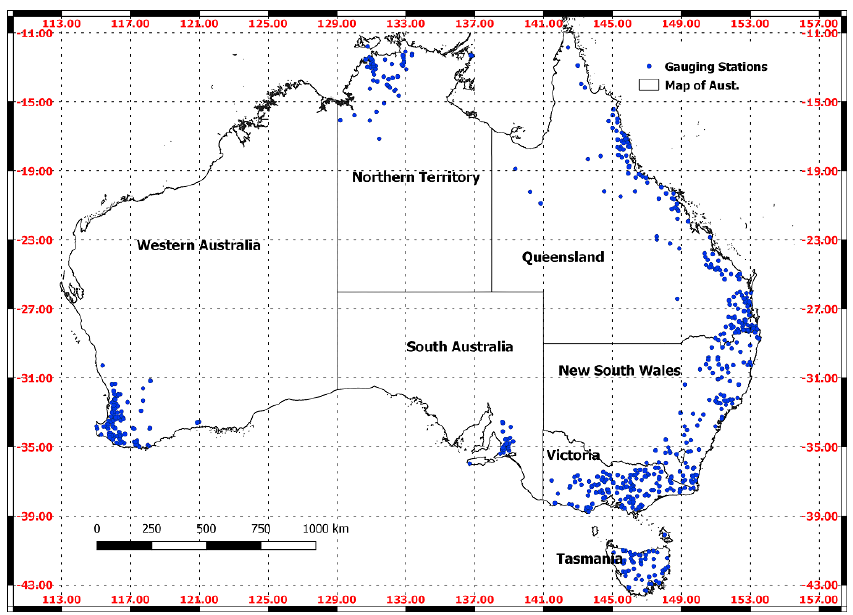
Figure 1. Geographical distribution of the selected 654 stations from all over Australia.